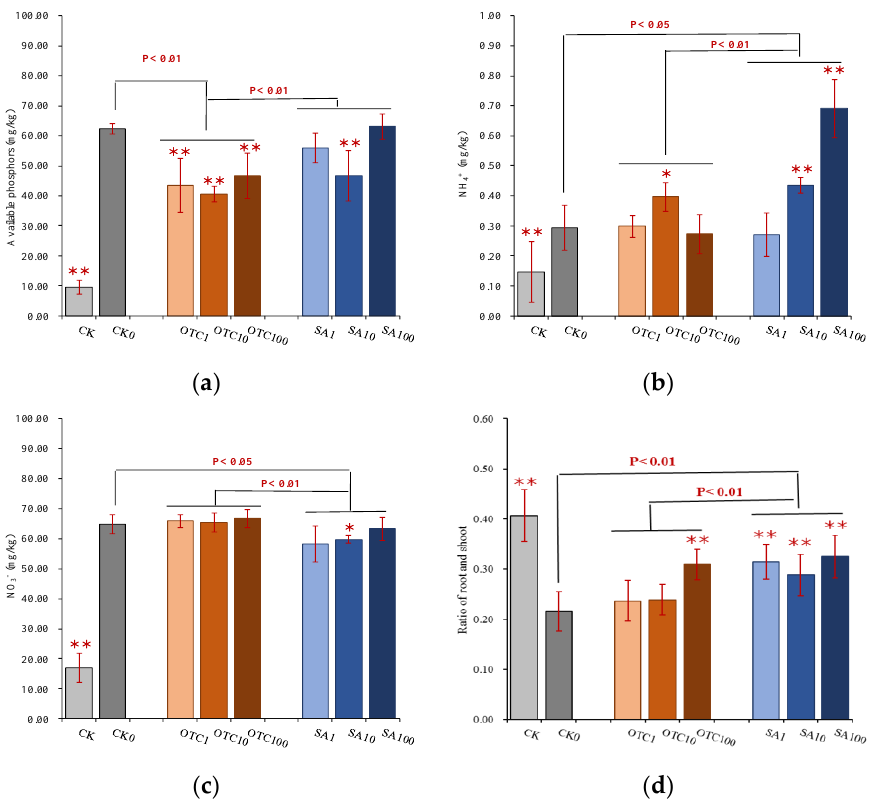
Figure 1. Changes of soil nutrient factors of rhizosphere soil in different treatments with or without plants. ( a ) Soil available phosphorus concentration; ( b ) Soil NH 4+ -N concentration; ( c ) Soil NO 3 − -N concentration; ( d ) Ratio of root and shoot. CK represents the soil without manure-based fertilizer; CK0 is the soil with manure-based fertilizer at 0 mg/kg antibiotic concentration; OTC1 is the soil with manure-based fertilizer at 1 mg/kg OTC concentration; OTC10 shows the soil with manure- based fertilizer at 10 mg/kg OTC concentration; OTC100 is the soil with manure-based fertilizer at 100 mg/kg OTC concentration; SA1 is the soil with manure-based fertilizer at 1 mg/kg SA concentration; SA10 indicates the soil with manure-based fertilizer at 10 mg/kg SA concentration; SA100 is the soil with manure-based fertilizer at 100 mg/kg SA concentration. * or ** represents significant differences ( p < 0.05 or p < 0.01) between each antibiotic treatment (e.g., OTC1, OTC10) and CK0, and p < 0.05 or p < 0.01 on the line represents significant differences between treatment groups such as control, OTC, and SA treatments. NH 4+ stands for soil ammonium nitrogen concentration; NO 3 − represents the soil nitrate nitrogen